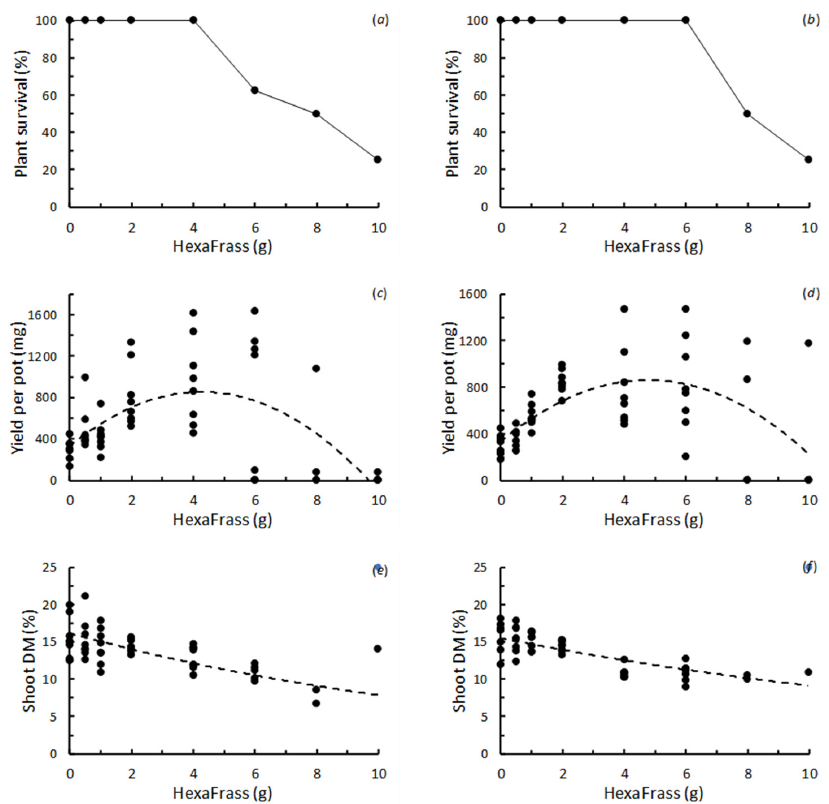
Figure 1. The effect of adding insect frass fertilizer (HexaFrass™; g per pot) on the survival to harvest, shoot yield per pot (mg), and percentage shoot dry weight of chicory ( a , c , e ) and ribwort plantain ( b , d , f ) grown under glasshouse conditions.